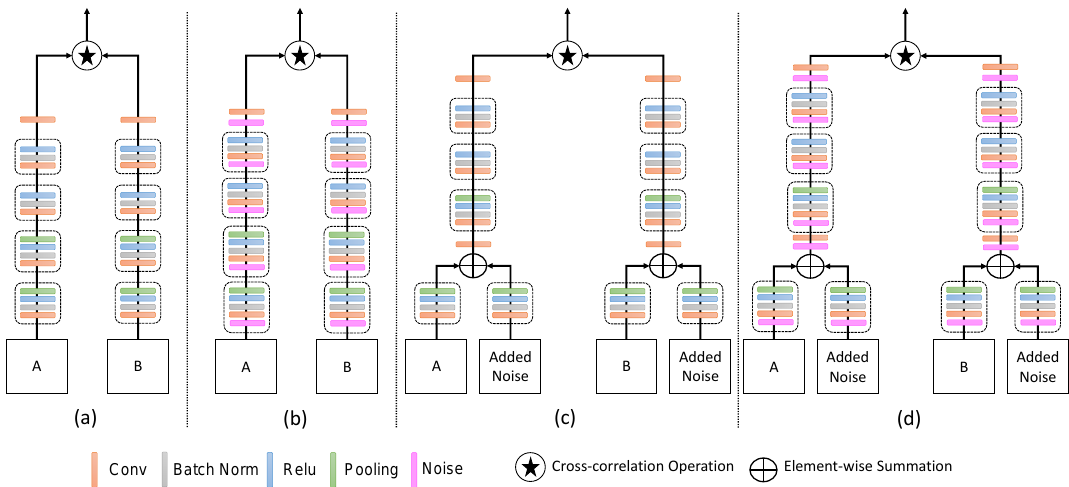
Figure 7. Added noise to inputs and different convolutional layers for SiameseFC and proposed framework. ( a ) shows the baseline SiameseFC, ( b ) indicates the SiameseFC with noise layers before convolutional layers, ( c ) represents the proposed framework without channel attention, and ( d ) shows the proposed framework with noise layers before convolutional layers and without channel